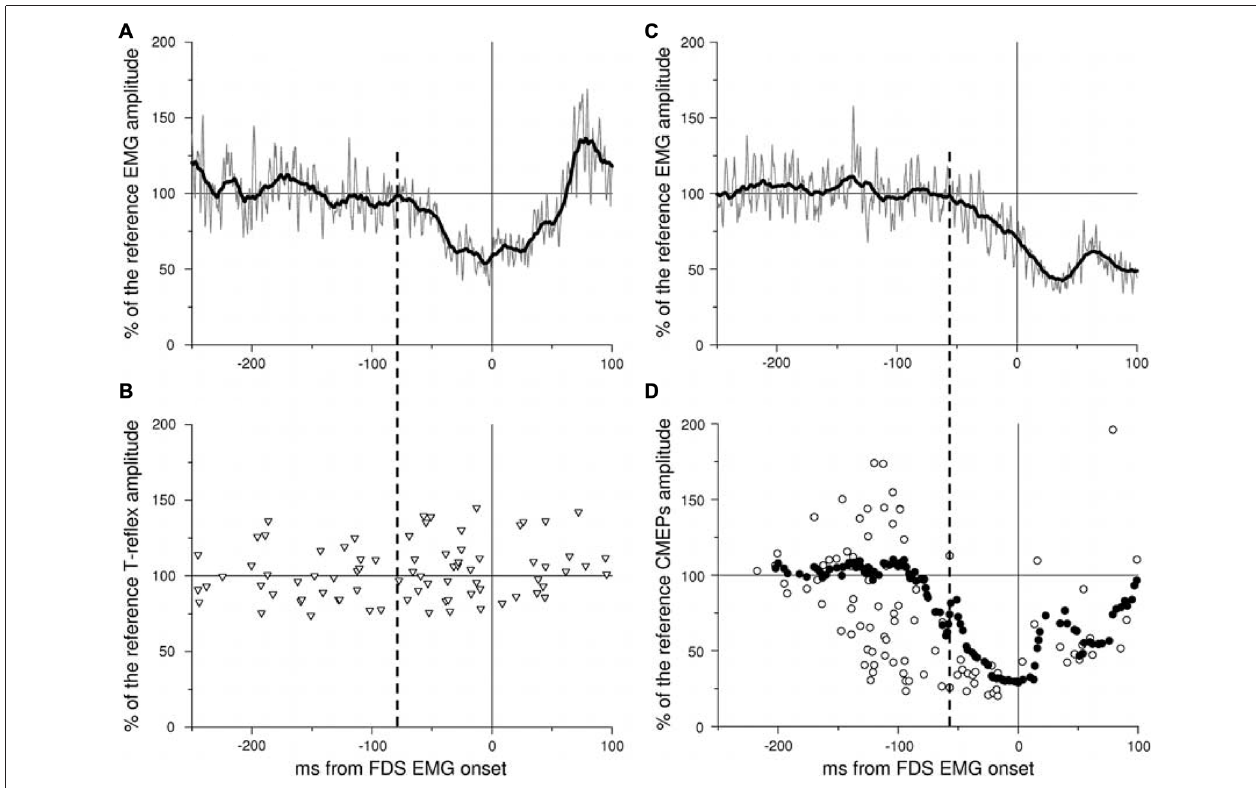
FIGURE 7 | Time course of spinal and cortico-spinal excitability in the resting BB before an index finger flexion. An inhibitory APA (iAPA) occurs in the BB EMG in two representative subjects (A,C) : in both cases rectified (gray trace) and integrated (black trace) EMG activity (average of 40 trials) is strongly reduced well in advance to the onset of FDS, taken as time 0. The time course of BB spinal excitability has been tested by means of tendon tap reflexes ( T-reflex, triangles in B) , while that of BB cortico-spinal excitability by Transcranial Magnetic Stimulation (TMS)-elicited cortical motor-evoked potentials ( CMEPs, open circles in D) . Each symbol marks amplitude and latency of one single evoked potential. Note that T-reflexes are un-modulated in size in the iAPA window, edged by the iAPA onset (vertical dashed line) and prime mover onset (vertical continuous line), whereas CMEPs are strongly inhibited. To better identify the onset of this inhibitory effect, the CMEPs time course has been integrated with the same time constant used for the EMG (filled circles). Both EMG and evoked potential amplitude are expressed as a percentage of their mean reference amplitude, i.e., that measured before the acoustic go signal. Reproduced from Caronni and Cavallari (2009b), © Springer-Verlag 2009, with permission of Springer